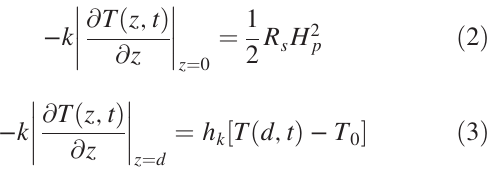
FIG. 8. Experimental and reconstructed Q vs E 3HZ015 at 2 K and 1.8